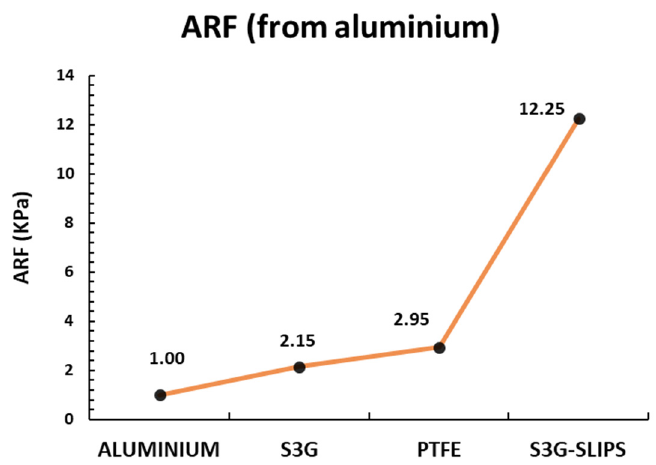
Figure 23. Graphs of the adhesion reduction factor of several coatings: aluminum substrate, PTFE, S3G, and S3G-SLIPS.